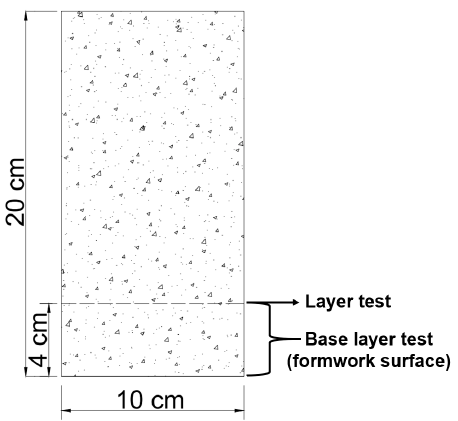
Figure 2. Specimen cutting scheme. Figure 3. Application of the colorimetric method.